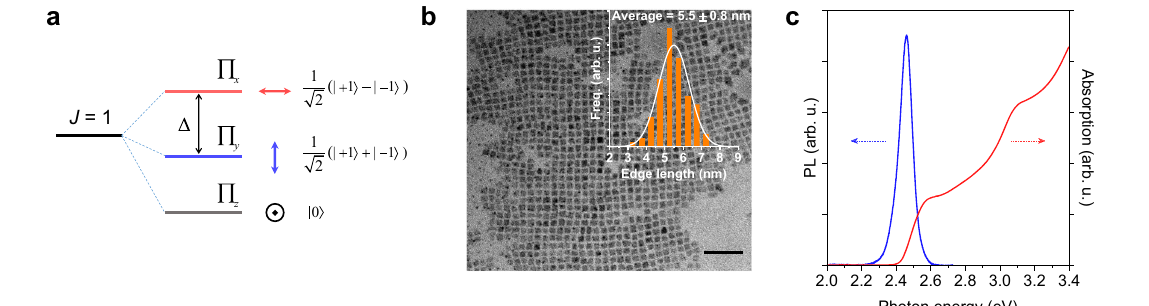
Fig. 1 | Properties of CsPbBr 3 NCs. a Fine structure splitting of the bright J =1 exciton triplet state in orthorhombic CsPbBr 3 NCs. The degenerate J =1 exciton state splits into three orthogonally and linearly polarized states Π x , Π y , and Π z as a result of the exchange interaction and shape anisotropy. The exciton spin up and down states are represented by|+1 〉 and| − 1 〉 , respectively. The laser beam